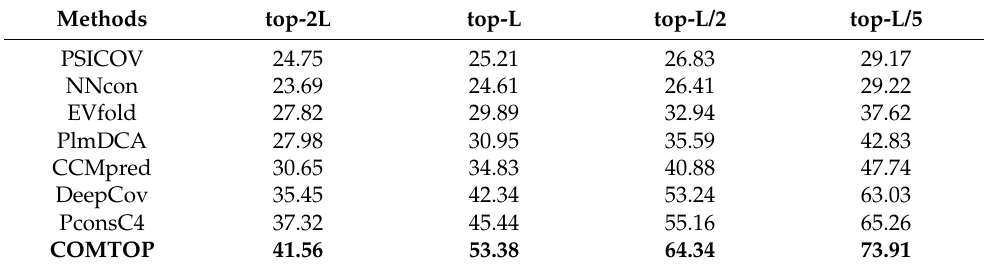
Table 8. The prediction accuracy of COMTOP with seven individual methods for 57 α -helical TM proteins